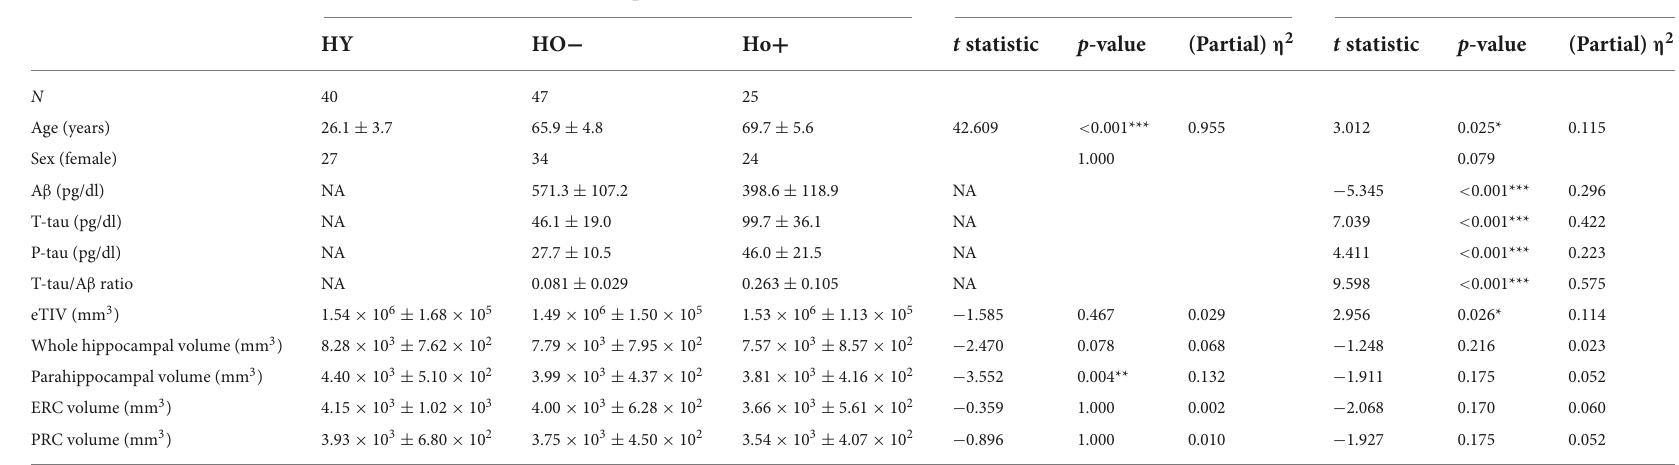
TABLE 1 Demographics, CSF, and volumetric assessments.